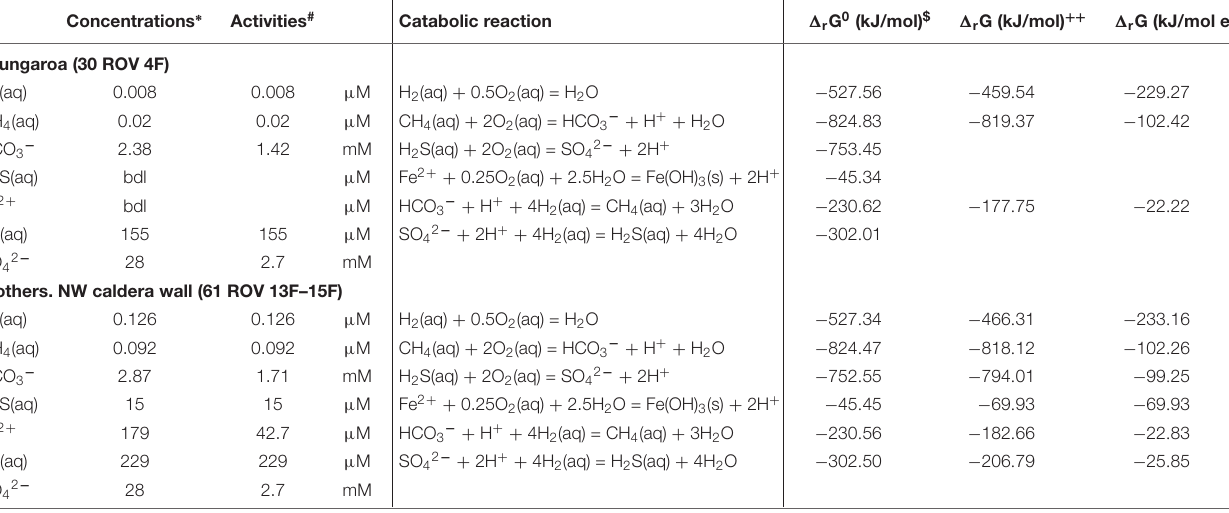
TABLE 1 | Compositions of diffuse fluids from two diffuse vent sites in the southern Kermadec arc and corresponding Gibbs energies for potential catabolic reactions. Concentrations ∗ Activities # Catabolic reaction